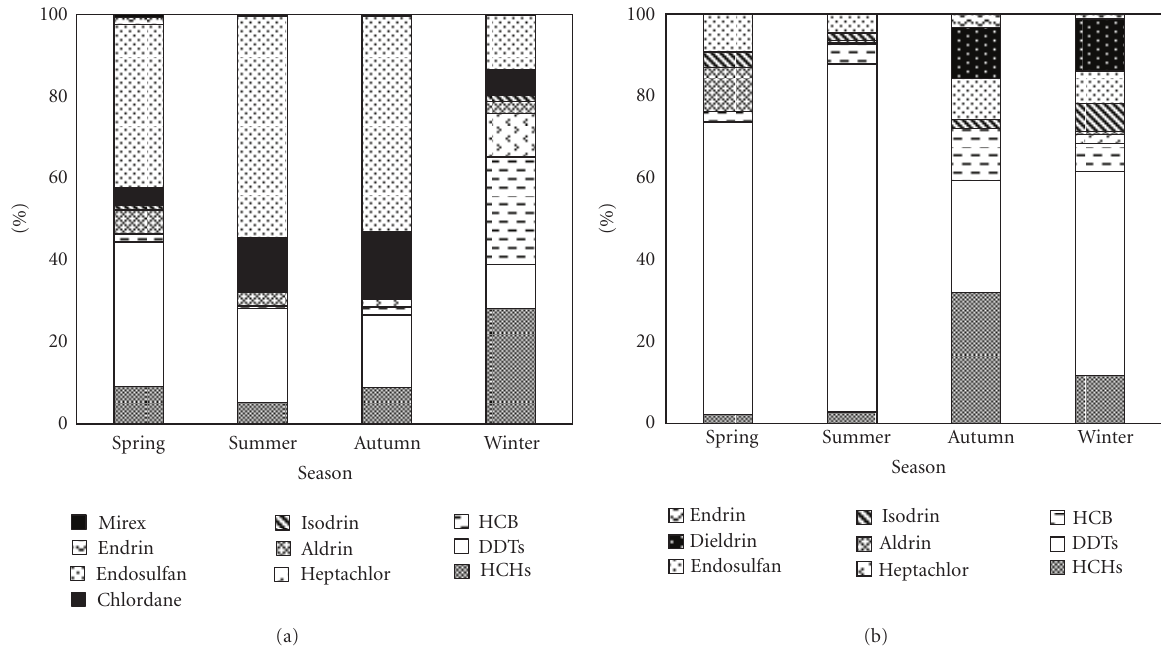
Figure 2: Seasonal variations of OCPs in the gas phase (a) and particle phase (b) at Lake Chaohu from March 2010 to February